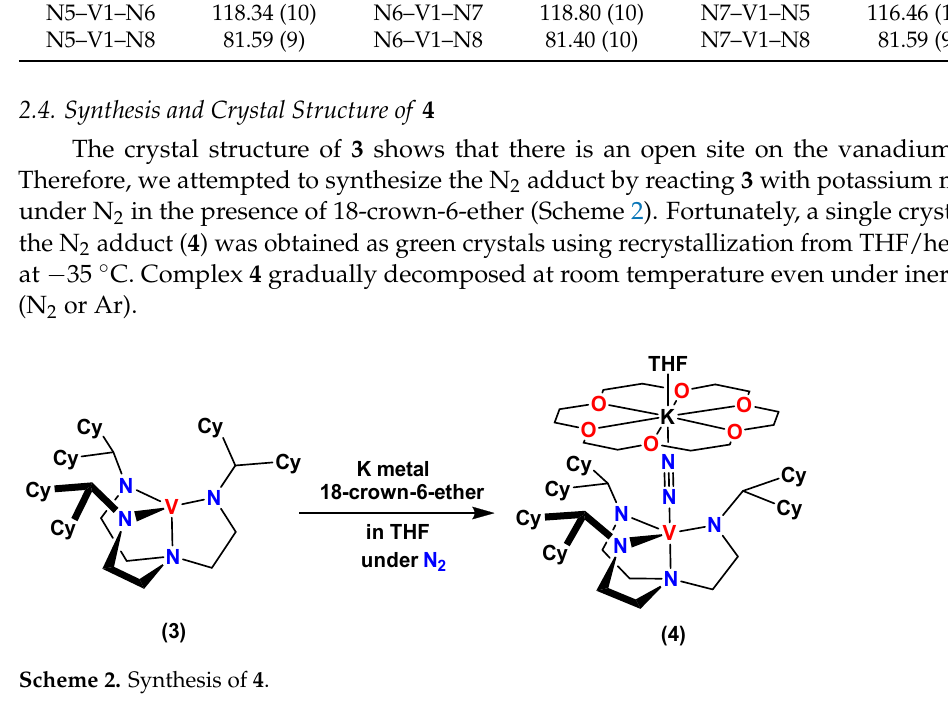
Figure 5. ( Left ) X-ray structure of 4 with the atom numbering scheme (50% probability thermal el- lipsoids). The hydrogen atoms, except for the hydrogen on the methine carbons neighboring on the terminal N atoms of the triamidoamine ligand, disordered atoms, and crystal solvates are omitted for clarity. ( Right ) Side view of space-filling model of 4 . The hydrogen atoms of THF and 18-crown- 6-ether are omitted, and the potassium ion, 18-crown-6-ether, and THF are shown in ball and stick model for clarity (C, H, N, O, K, and V are shown in gray, white, blue, red, pink, and green colors,